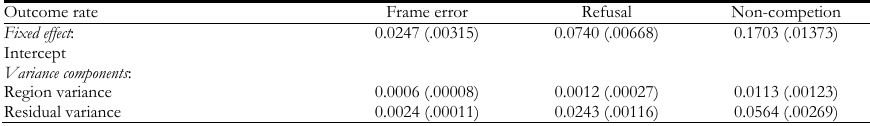
Null model for fram error, refusal and non-completion rates: solutions for fixed and random effects – 2005 Outcome rate Frame error